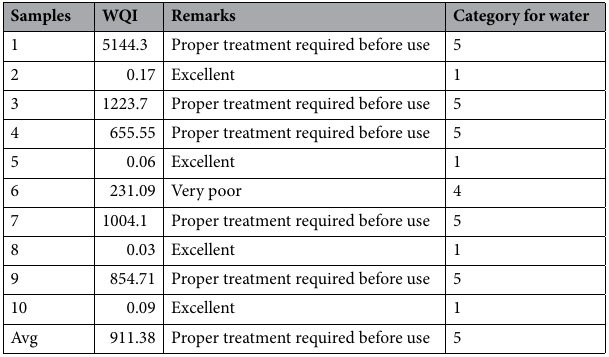
Table 6. Classification of the water quality index for individual parameter of water.